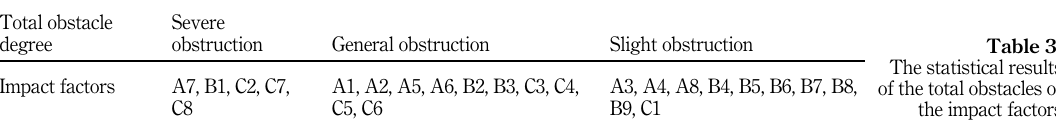
Table 3. The statistical